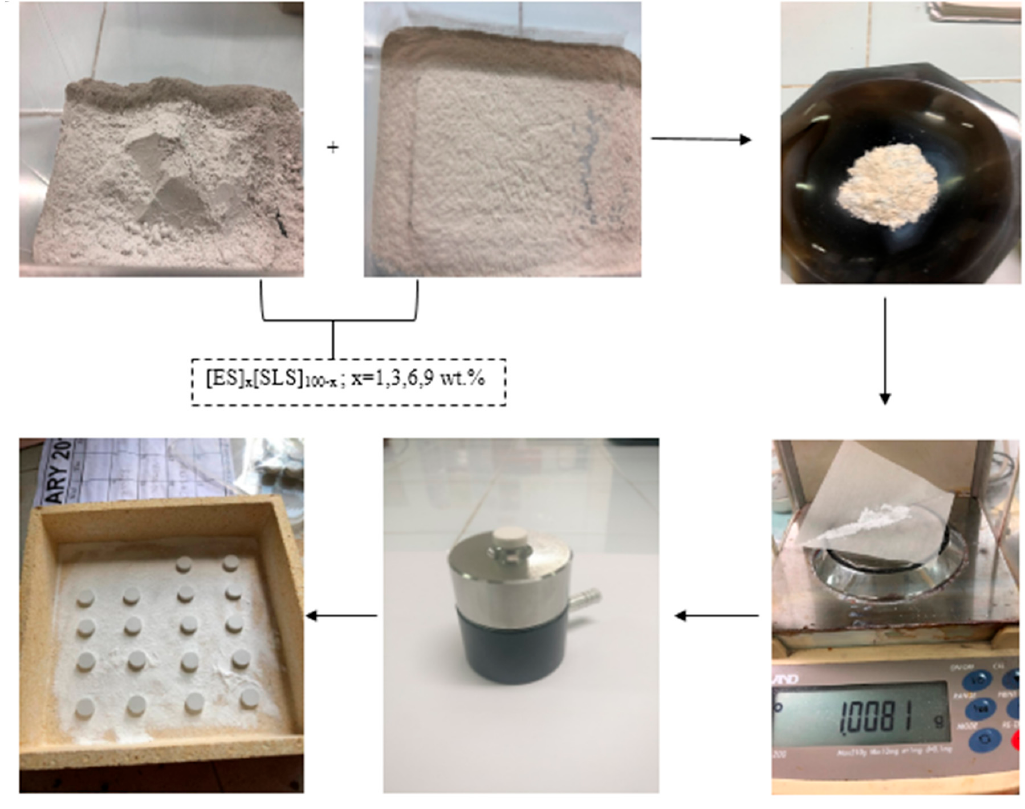
Figure 1. Schematic diagram of sample preparation.